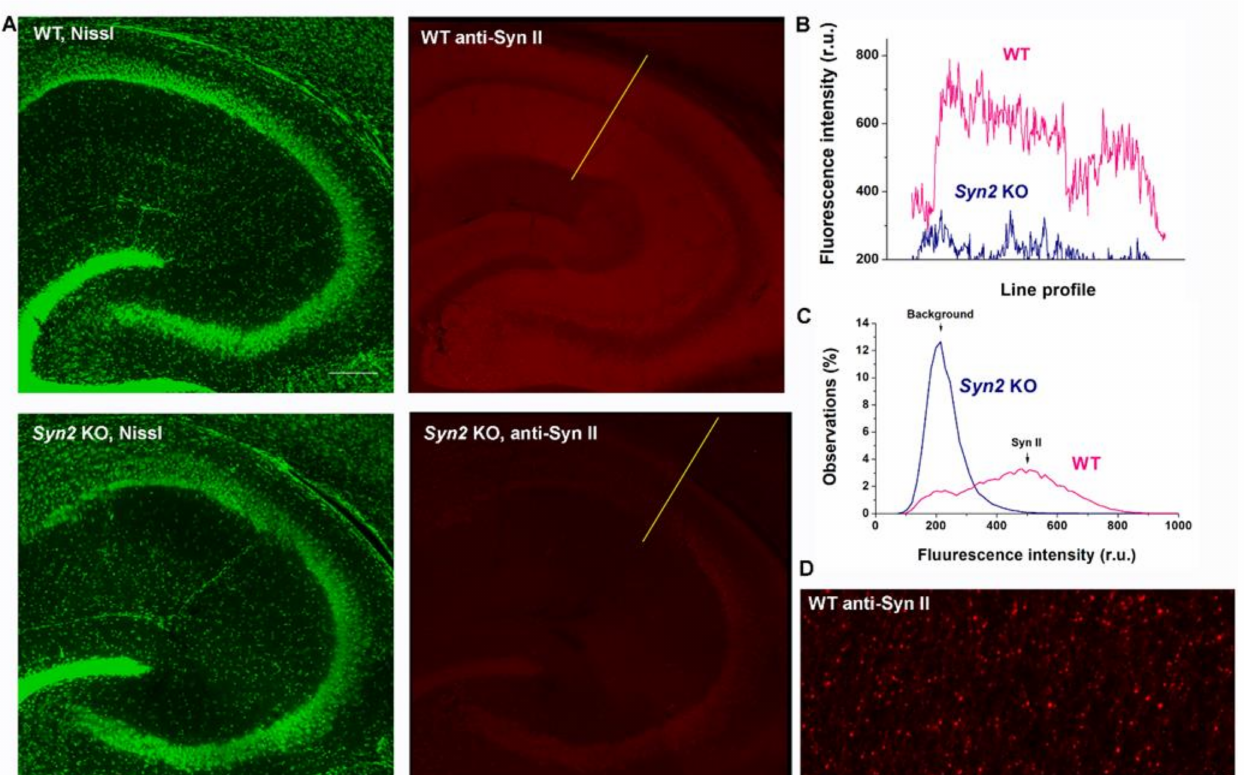
Figure 1. Immunohistochemical detection and quantification of Syn II in the CA1 region of the hippocampus. ( A ) Horizontal slices through the middle hippocampus stained using a fluorescent Nissl (Neurotrace 500/525) to provide an anatomical reference point and immunolabeled for Syn II. Green channel (left): Nissl staining shows similar anatomy for the WT and Syn2 KO slices. Red channel (right): immunolocalization of Syn II. The left and right panels show identical fields of view. Note a robust Syn II signal detected in the WT slice but only background fluorescence in the Syn2 KO slice. Scale bars: 200 µ m. ( B ) The fluorescence intensity line profiles for the Syn II signal (red channel) over the different cell layers of the CA1 region for these slices as denoted by the yellow lines in panel A. ( C ) The distributions of pixel flurescence intensities for the anti-Syn II signal (red channel) for WT and Syn2 KO slices. Note a single peak (background) for the Syn2 KO strain and two peaks (background and Syn II signal) for WT. p < 0.001 per K.-S. test. ( D ) Syn II immunolabeling has a punctate pattern in WT slices, as expected from Syn II being locatized to nerve terminals. Scale bar: 10 µ